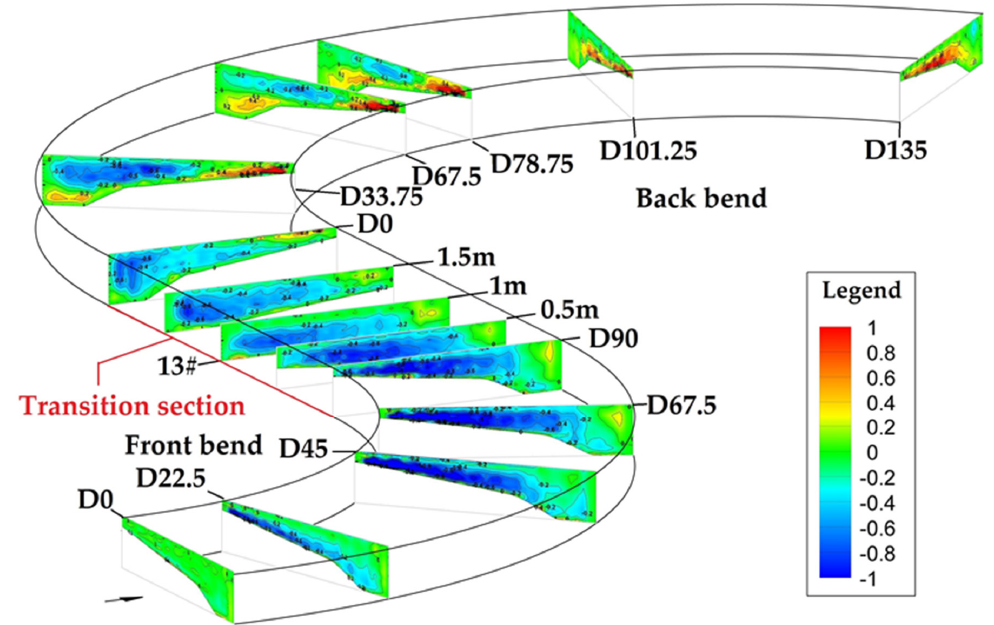
Figure 7. Distribution of the circulation intensity along the continuous bend at Q3.